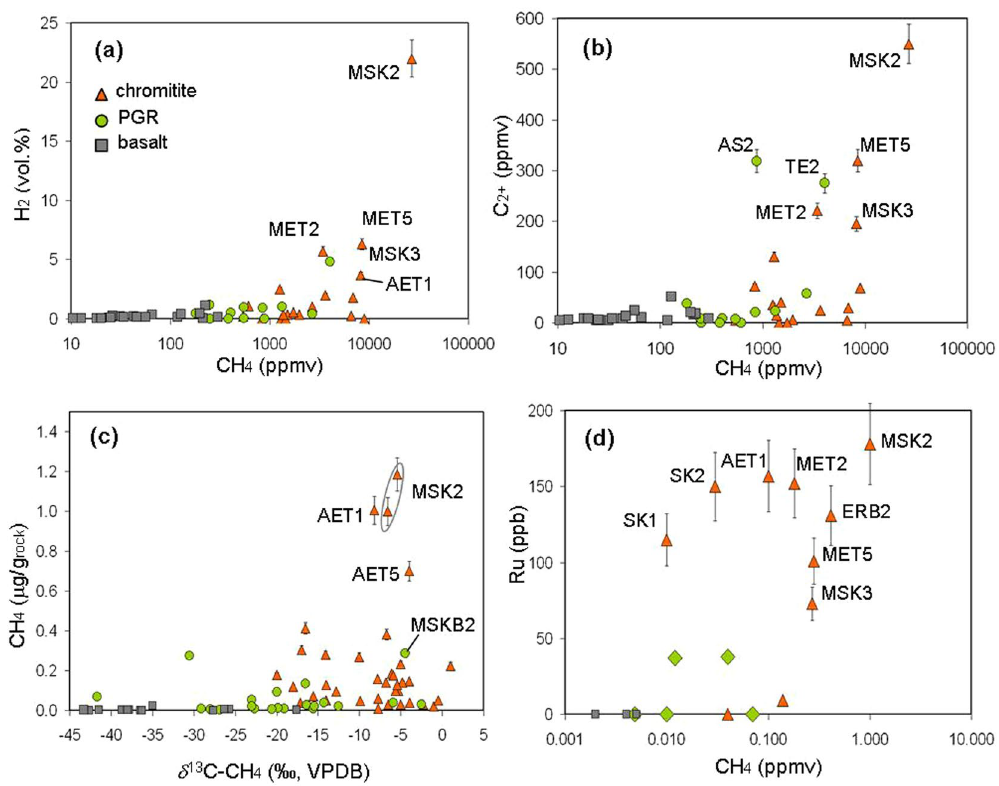
Figure 3. Correlations between concentrations of methane, other gases and ruthenium in the investigated rocks. ( a ) Methane vs hydrogen concentration; ( b ) methane vs ethane + propane + butane concentration; ( c ) methane concentration vs. stable C isotope composition ( d ) methane vs. ruthenium concentration. PGR: Peridotites, Gabbros and Rodingites; MSK2 (Othrys ophiolite) chromitite showed the highest amounts of methane, hydrogen, C 2 + alkanes and ruthenium. AET samples (Vourinos ophiolite) showed the second highest CH 4 and Ru